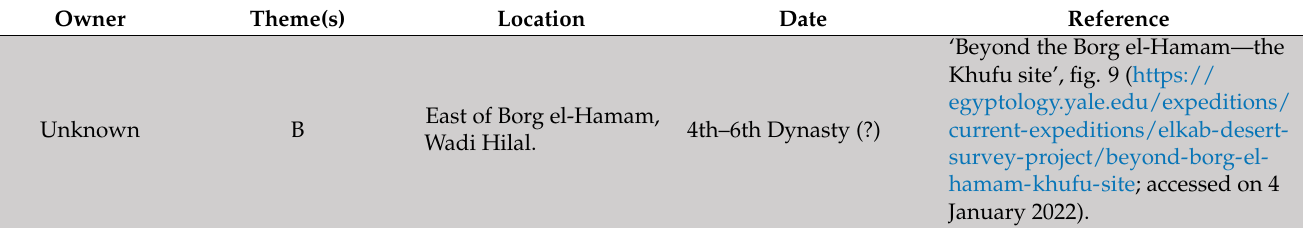
Table 3. Hedgehog-head boats represented in